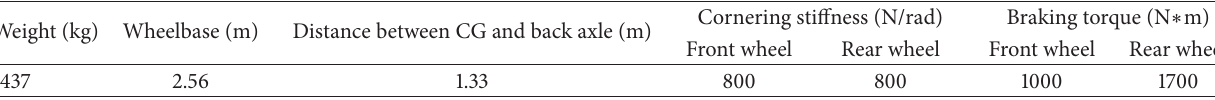
Table 1: Car structure